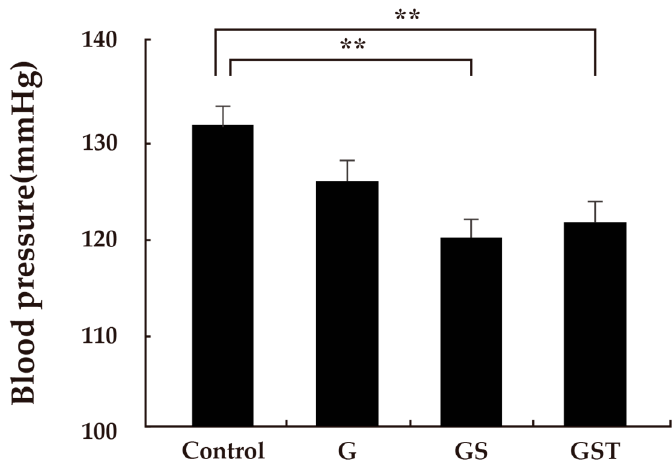
Figure 3. Values of systolic blood pressure after viewing the four rooftop images. Control: no vegetation with concrete floor; type G: grass vegetation; type GS: grass-shrubs vegetation; type GST: grass-shrubs-trees vegetation; n = 15, mean ± SE; **, p < 0.01.